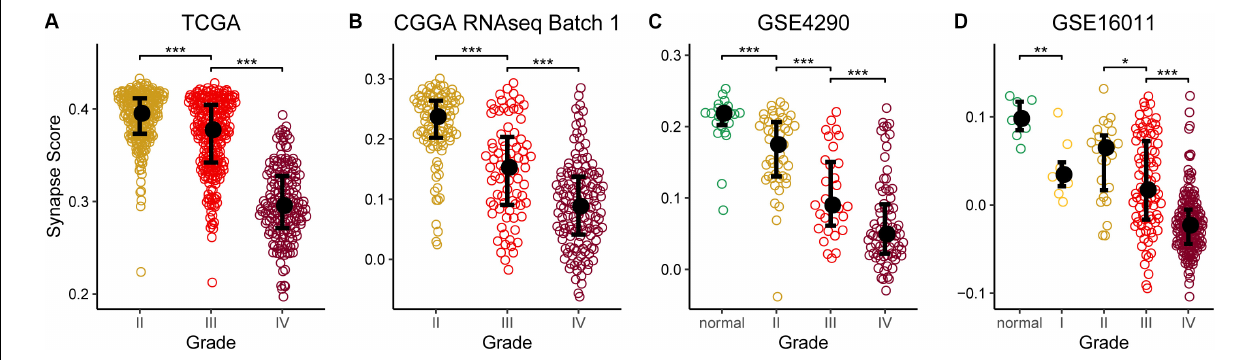
FIGURE 3 | Synapse scores were significantly lower in higher grade gliomas. (A) TCGA lower grade glioma (LGG) and glioblastoma multiforme (GBM). (B) CGGA RNAseq batch 1. (C) GSE4290. (D) GSE16011. Significances of difference between two groups were analyzed by two-side Wilcoxon rank sum test. * p < 0.05, ** p < 0.01, *** p <